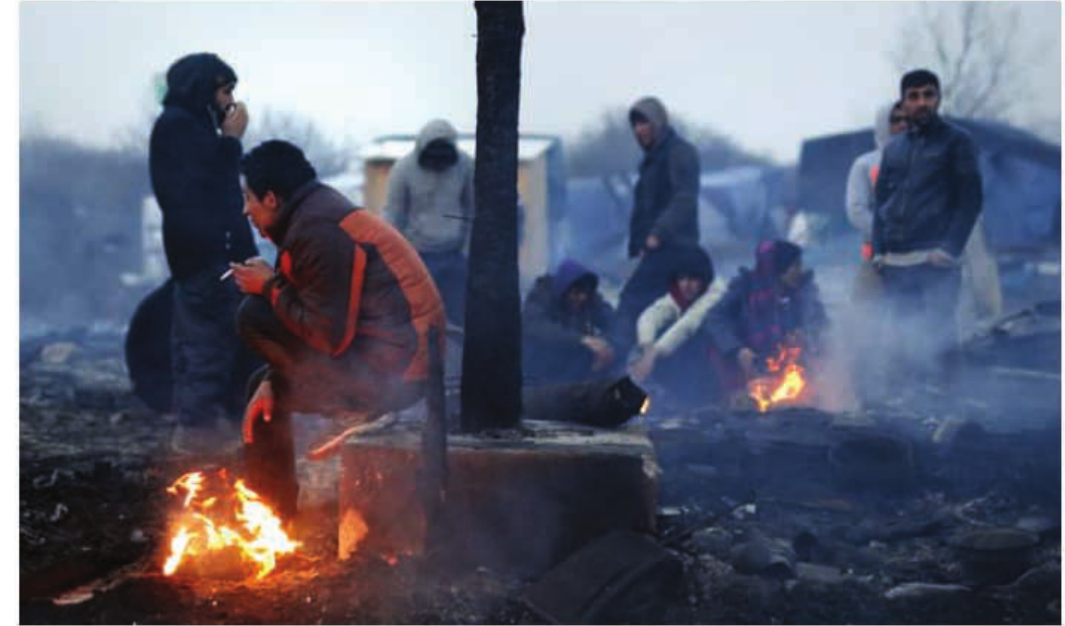
Figure 5: Migrants keep warm during the dismantling of the ‘Jungle’ makeshift camp in Calais. Photograph: Thibault Vander- mersch/EPA (GUA), https://www.theguardian.com/uk-news/2016/aug/30/dover-mp-warns-against-tit-for-tat-battles-with- france-over-border-security (date of last access: